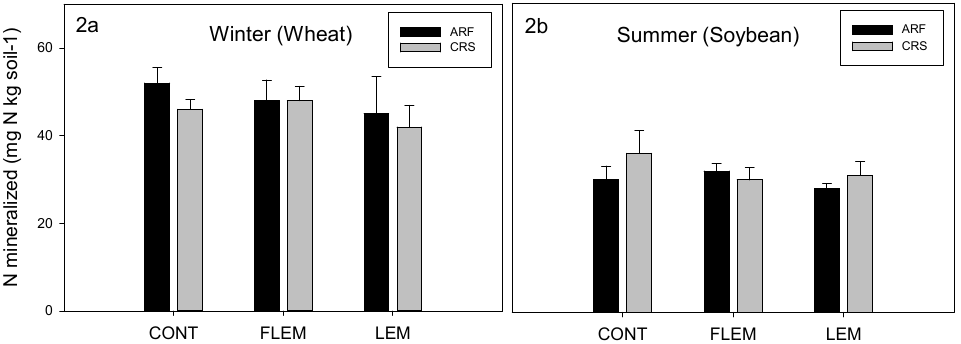
Figure 2. Amount of N mineralized (minus the amount of mineralized N in initial soils sampled after treatment application and analyzed before incubation) from plots managed previously under an annual ryegrass/fallow rotation (ARF) and under a cereal rye/ edamame soybean rotation (CRS); α = 0.05. No letters indicate no significant differences.